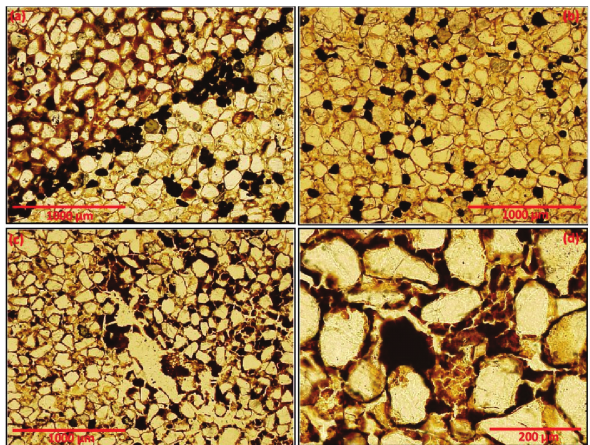
Figura 4. Fotomicrografias dos perfis 29 e 30, mostrando: (a) concentração de